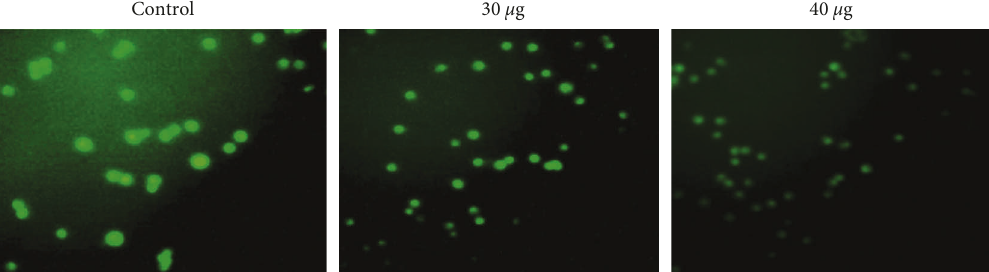
Figure 9: MOLT4 cell line mitochondrial membrane potential was affected by CTCANc. These fluorescence images showed a decreased mitochondrial membrane permeability after exposure to CuO-TiO 2 -chitosan-amygdalin nanocomposites.